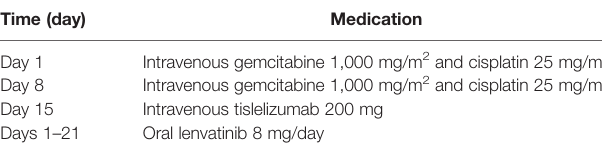
TABLE 1 | The systemic sequential therapy scheme.